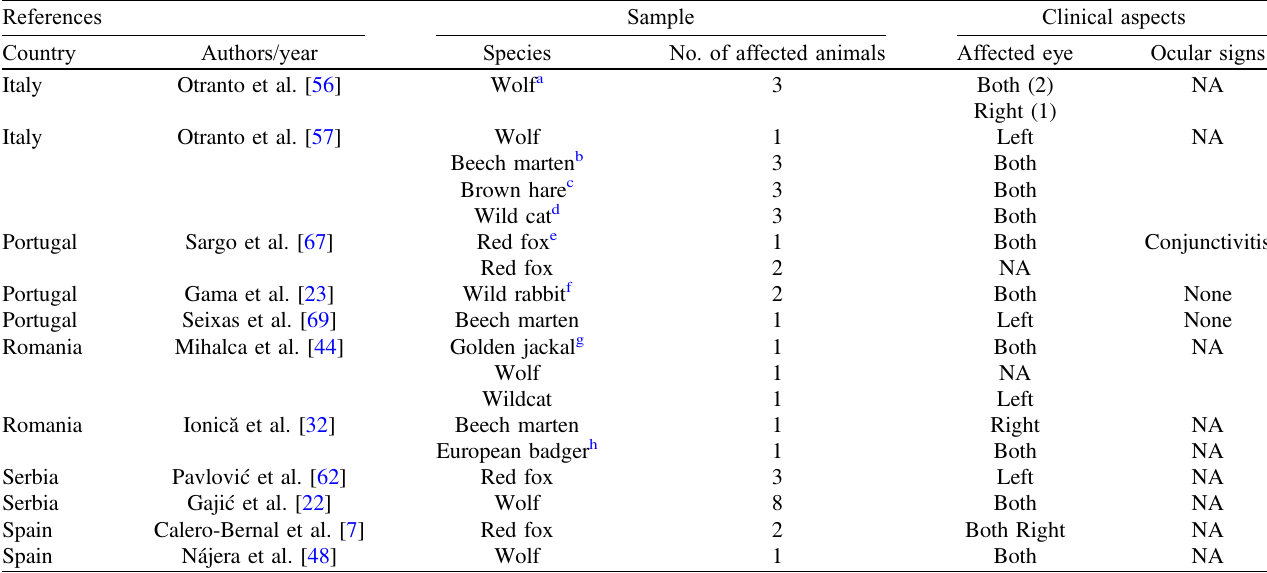
Table 2. Features of the studies included in the qualitative analysis regarding T . callipaeda infection in wildlife in